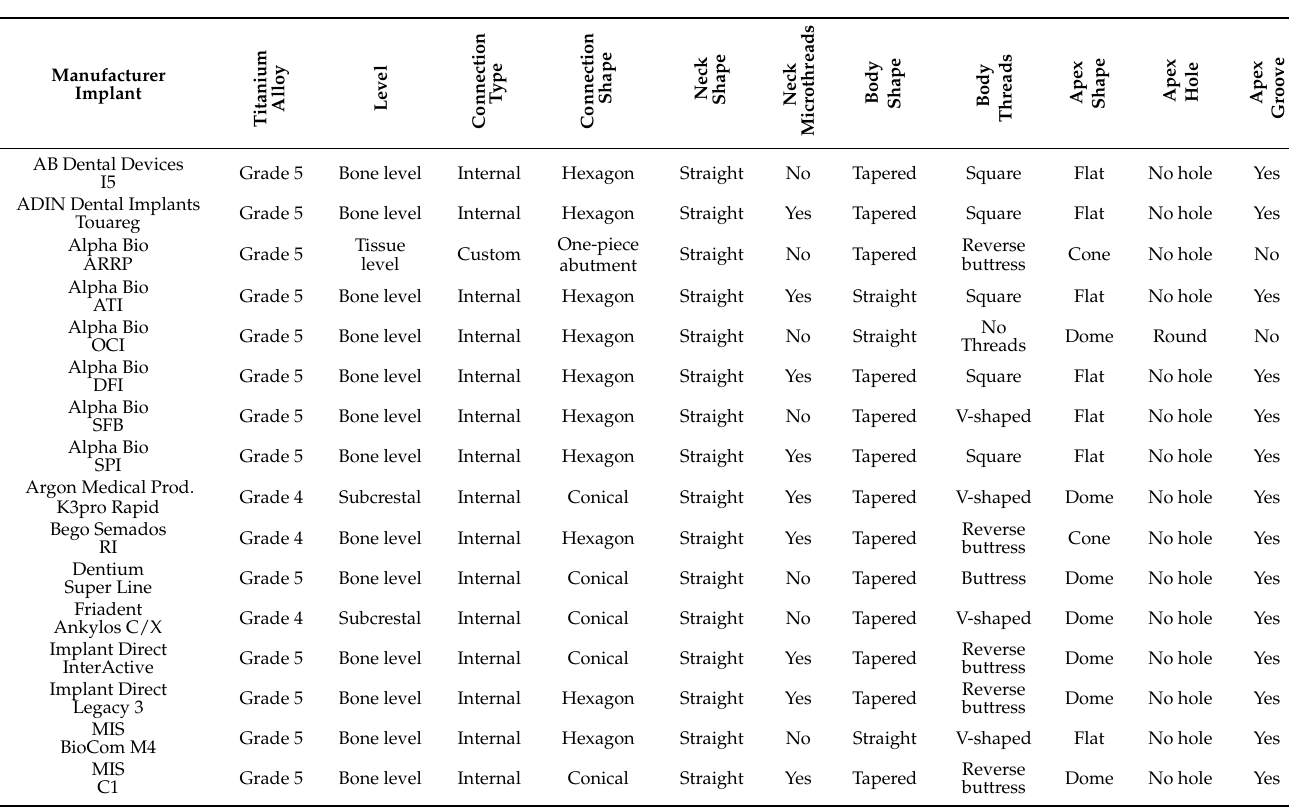
Table 1. Technical features of dental implant designs used in this study. Data were confirmed